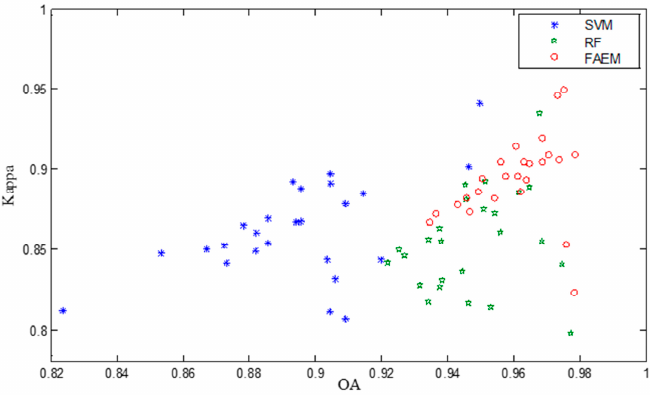
Figure 9. Kappa and OA of 25 GF-1 images with SVM, RF and proposed approach.